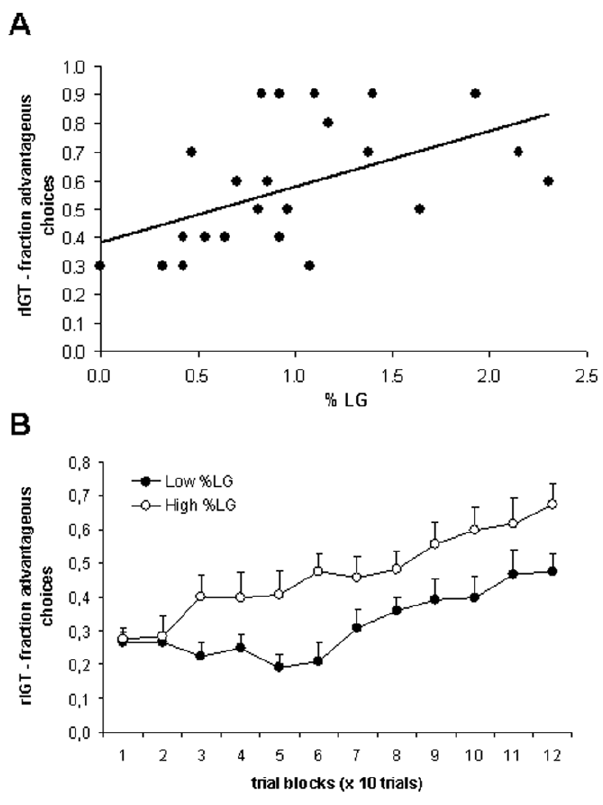
Figure 2. Performance on the rodent Iowa Gambling Task. (A) In young-adult males and females (approx. 3 months old) there was a positive correlation between task performance on the rIGT, as indicated by the number of advantageous choices made during the last block of 10 trials, and %LG (n=24, r=0.521, p=0.009). Thus, animals with higher LG scores perform better on a higher cognitive decision-making task. (B) When dividing the experimental group in ‘Low’ and ‘High’ LG animals by median split, a significant interaction effect between %LG and trial block emerged (10 trials per block; repeated measures ANOVA, main effect of group: F(1,22)=6.485, p=0.018; LG-group * trial block interaction: F (11,242) =1.807, p =0.05; trial block: F (11,242) =14.544, p=0.001). This suggests delayed learning in the ‘Low’ LG group, particularly in the first part of the task.